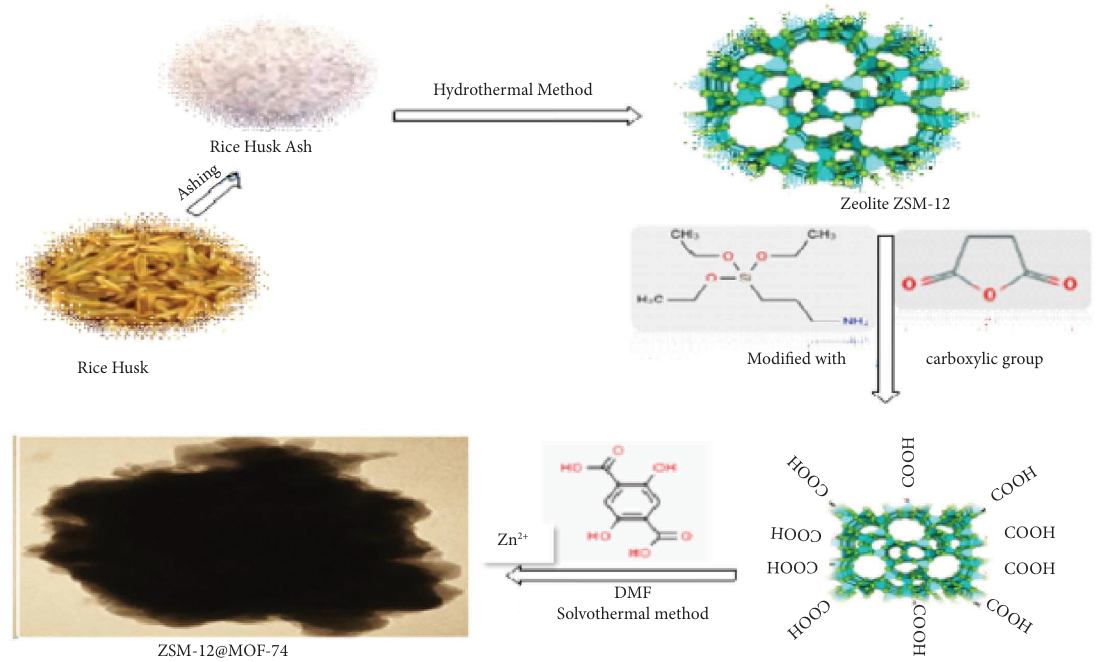
Figure 8: Synthesis of ZSM-12@MOF-74 core@shell through solvothermal growth of MOF-74 on hydrothermal presynthesized ZSM-12 zeolite surface modifed from